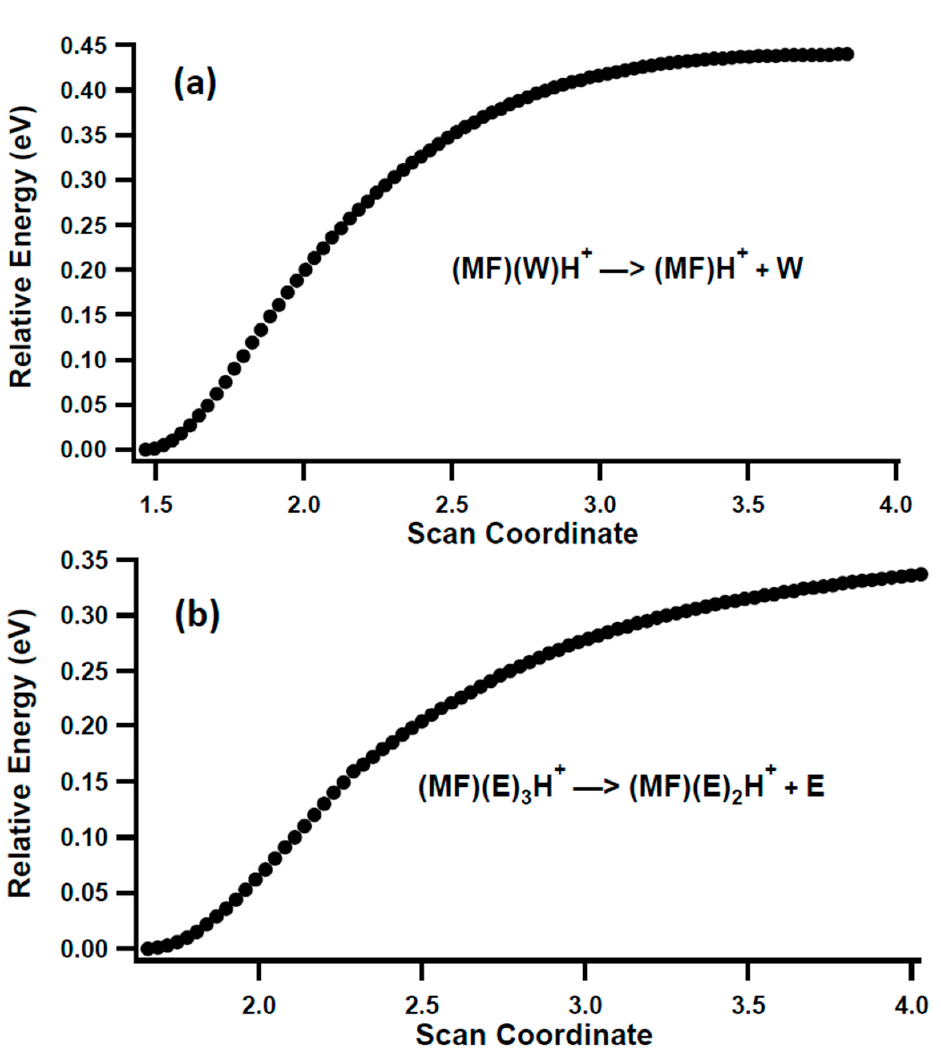
Figure 5. Relaxed potential energy scan of the dissociation of ( a ) MFWH + and ( b ) MF(E) 3 H + at the B3LYP/6-311+G(d,p) level of theory.